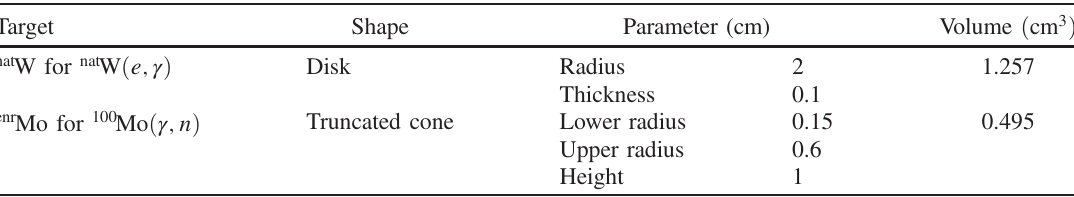
TABLE II. Geometrical parameters of the target assembly.